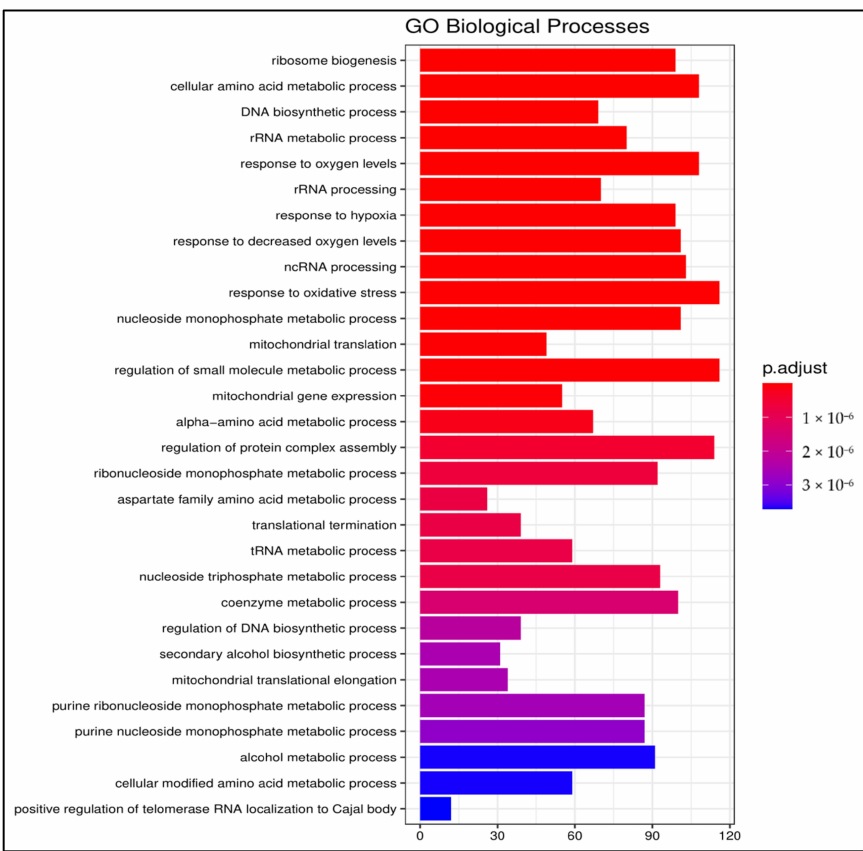
Figure 2. Biological process enrichment upon treating Caco-2 cells with 13-HPODE. Top enriched gene ontology (GO) biological processes in 13-HPODE-treated differentiated Caco-2 cells relative to untreated control cells (adjusted p <